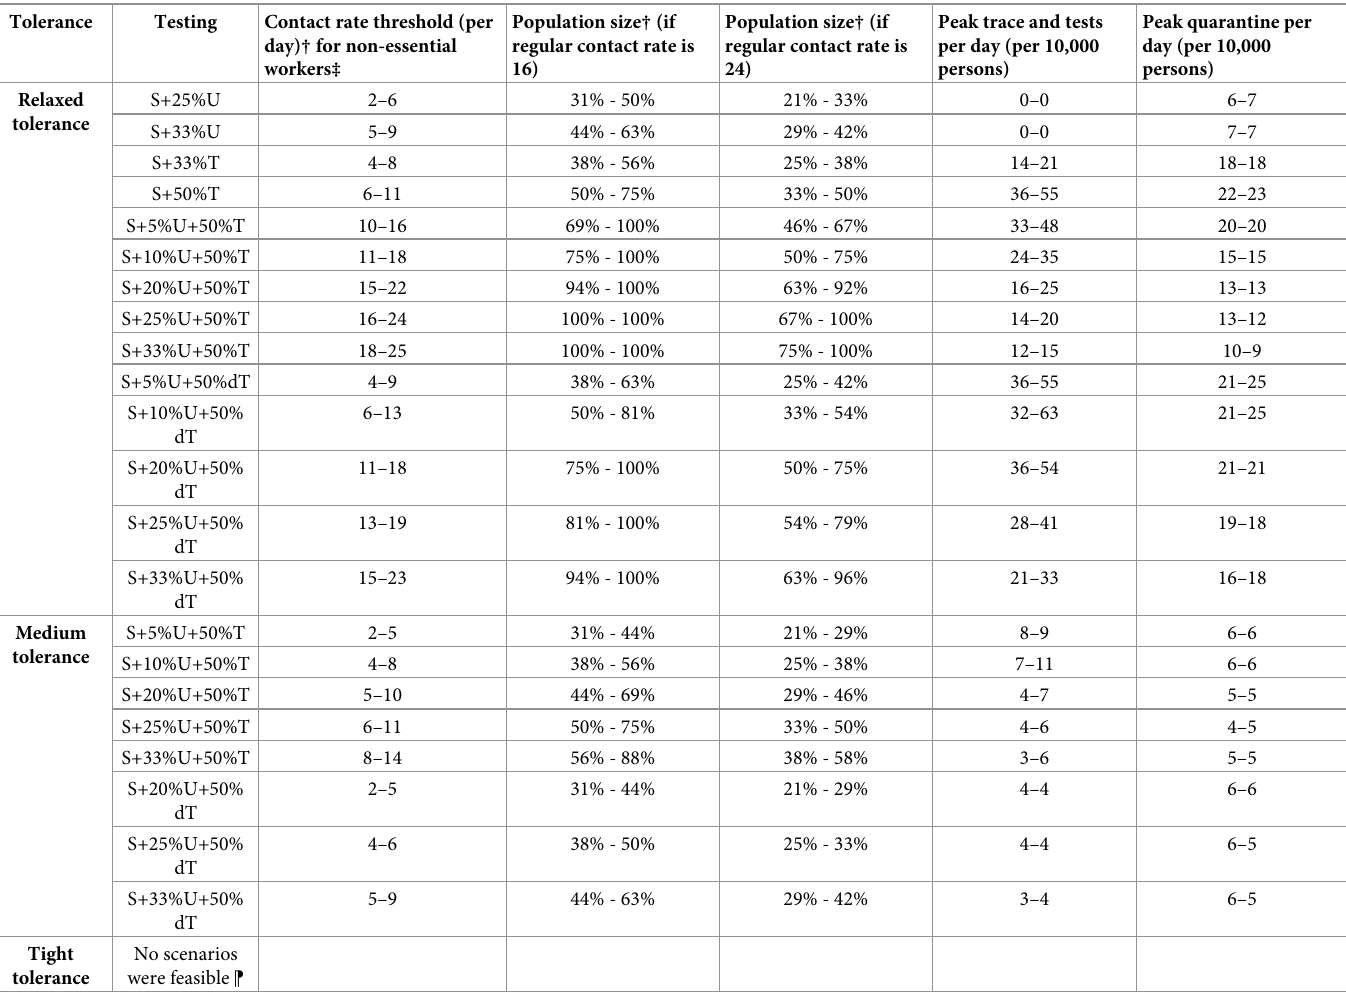
Table 1. Feasible combinations ⁋ of testing, contact rate, and population size on campus for effective control of a disease outbreak in the absence of a vaccine. Tolerance Testing